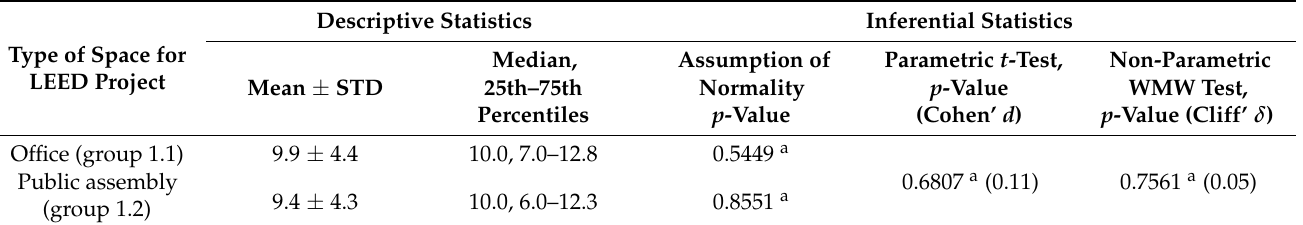
Table 3. Case 1: comparison of EAc7 (Optimize Energy Performance) credit achievement of groups 1.1 and 1.2 without considering project size in LEED-NC v4 certified projects.